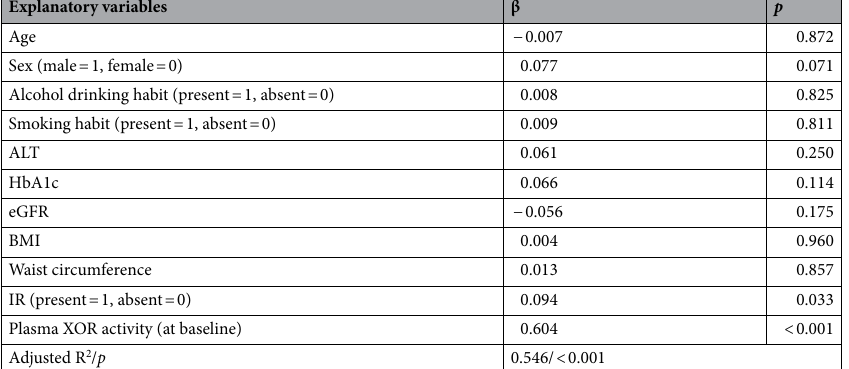
Table 3. Multivariable linear regression analysis of possible factors associated with plasma XOR activity at 12-month follow-up examination. Values shown represent standardized partial regression coefficient (β values) and level of significance. ALT alanine aminotransferase, HbA1c glycated hemoglobin, eGFR estimated glomerular filtration rate, BMI body mass index, IR insulin resistance, XOR xanthine oxidoreductase.